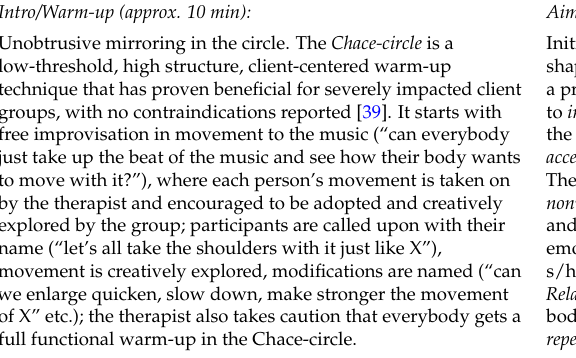
Table B1. Overview of the DMT Intervention “Therapeutic Mirroring for Autism”